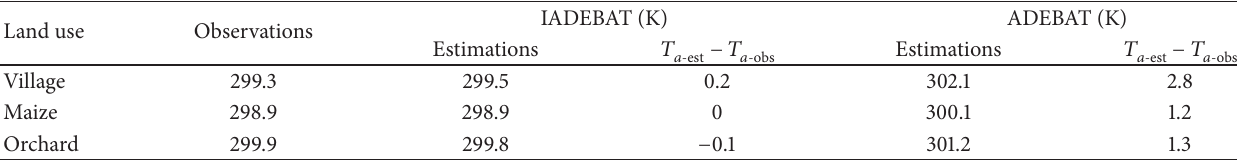
Table 3: Air temperatures measured by meteorological stations and retrieved by the IADEBAT and the ADEBAT models from three different land use types on July 10th,